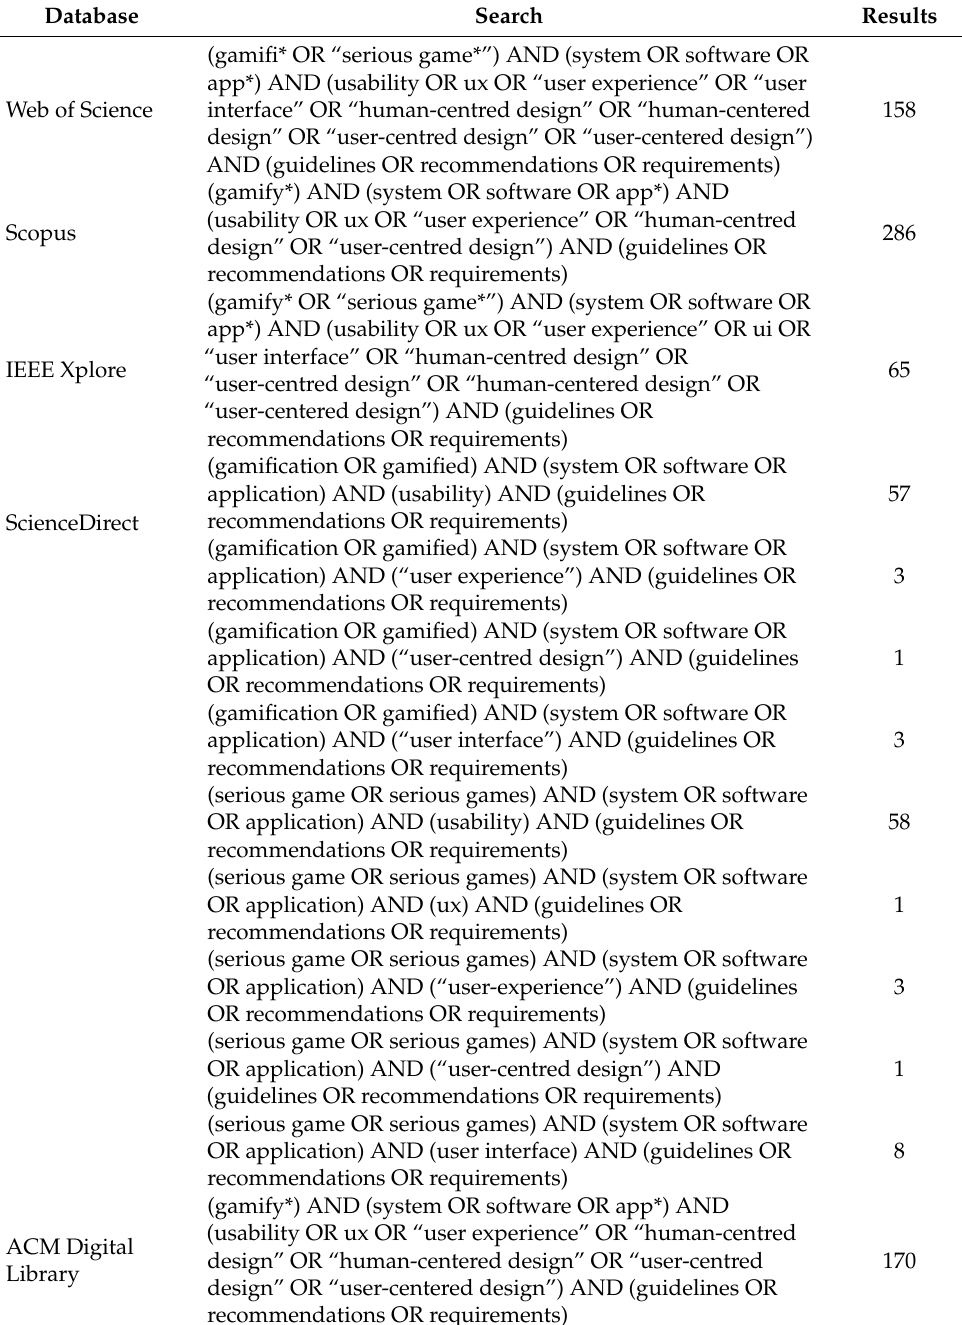
Table 1. Searches in